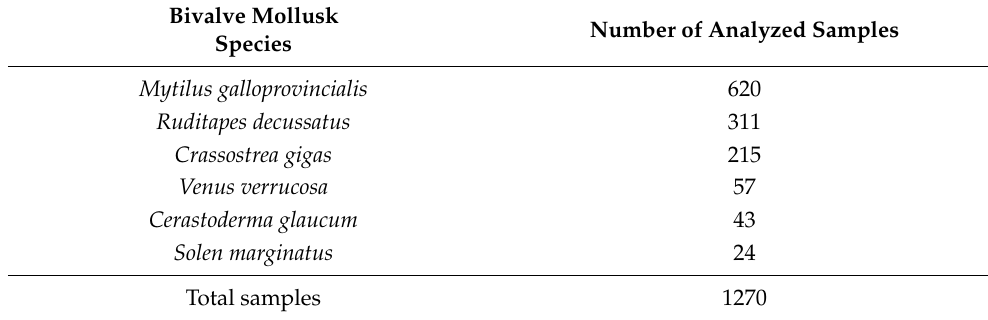
Table 1. Shellfish samples analyzed in